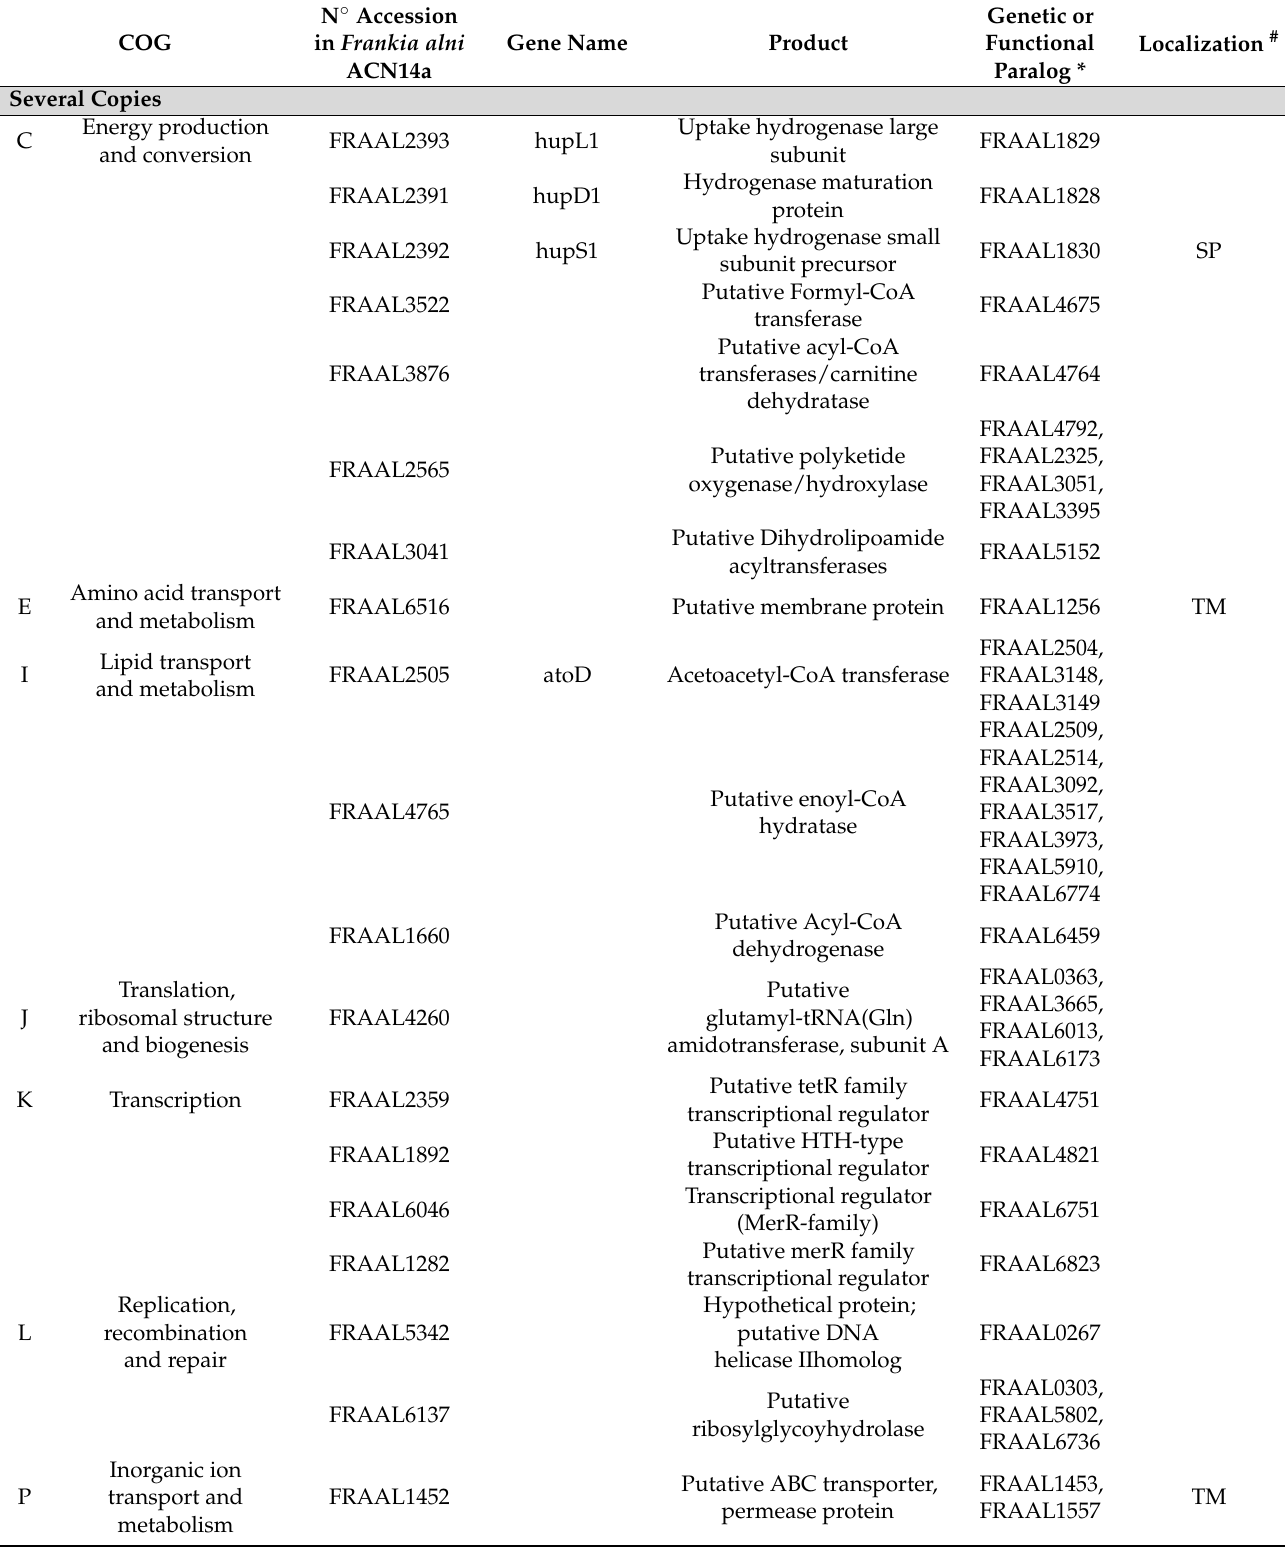
Table 5. List of specific genes found in Sp − genomes and absent in Sp+ genome from Cluster